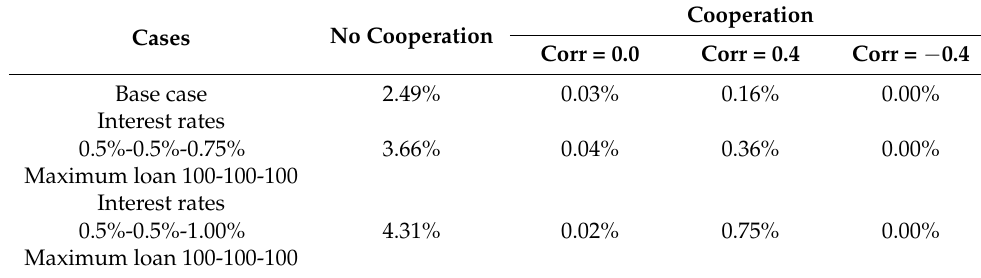
Table 9. Probability of bankruptcy in different